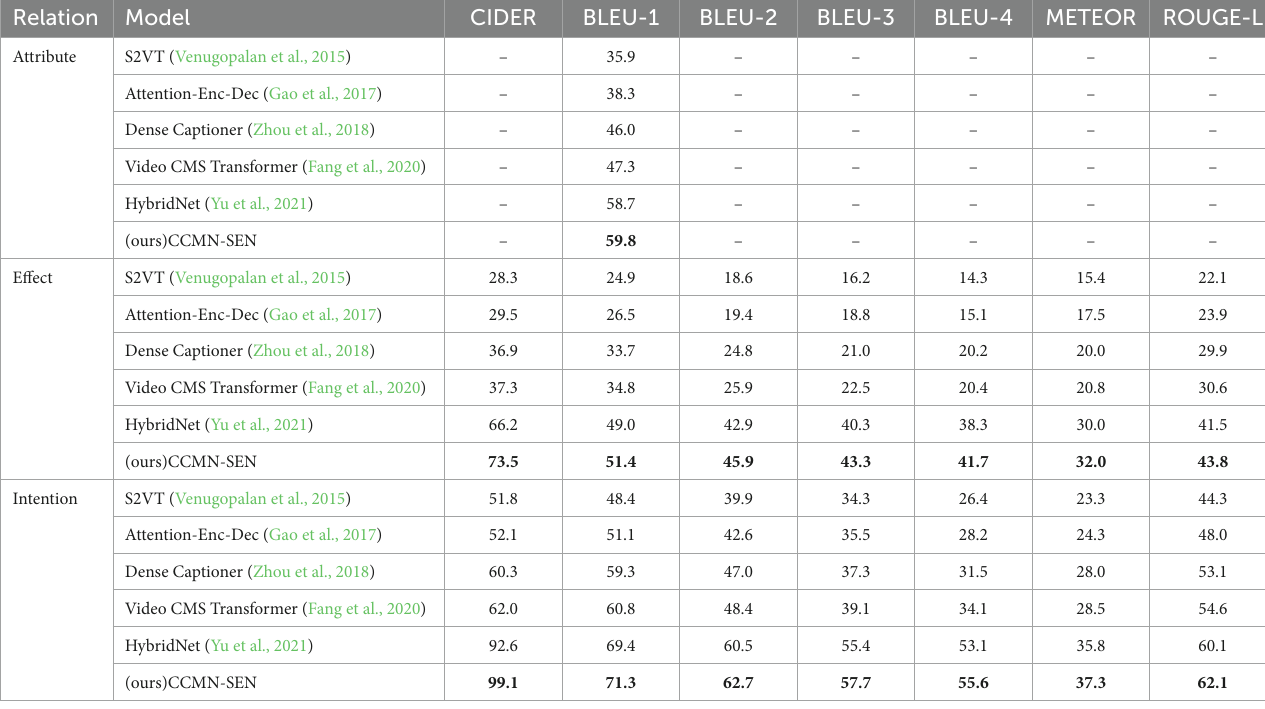
TABLE 1 Evaluation of V2C completion task using CIDER, BLEU, Rouge, and Meteor metrics. Relation